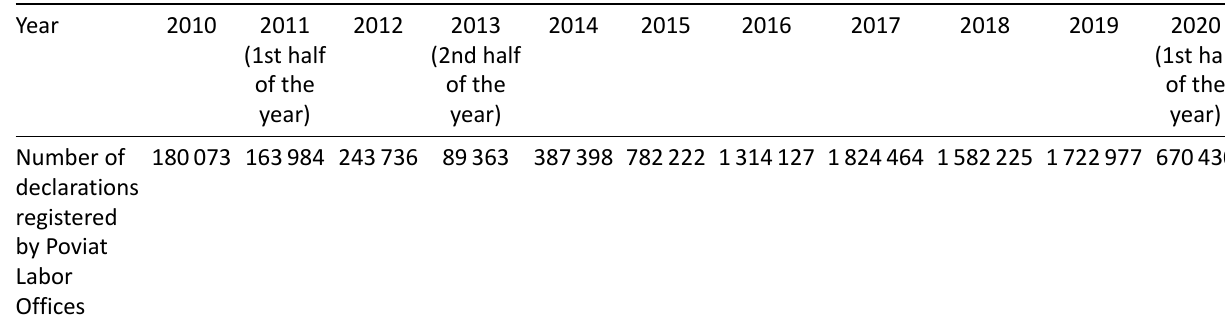
Table 3. Declarations on entrusting work to a foreigner in 2010–2020. (Only citizens of Armenia, Belarus, Georgia, Moldova, Russia and Ukraine may work on the basis of the declaration on entrusting work to a foreigner. This is a simplified